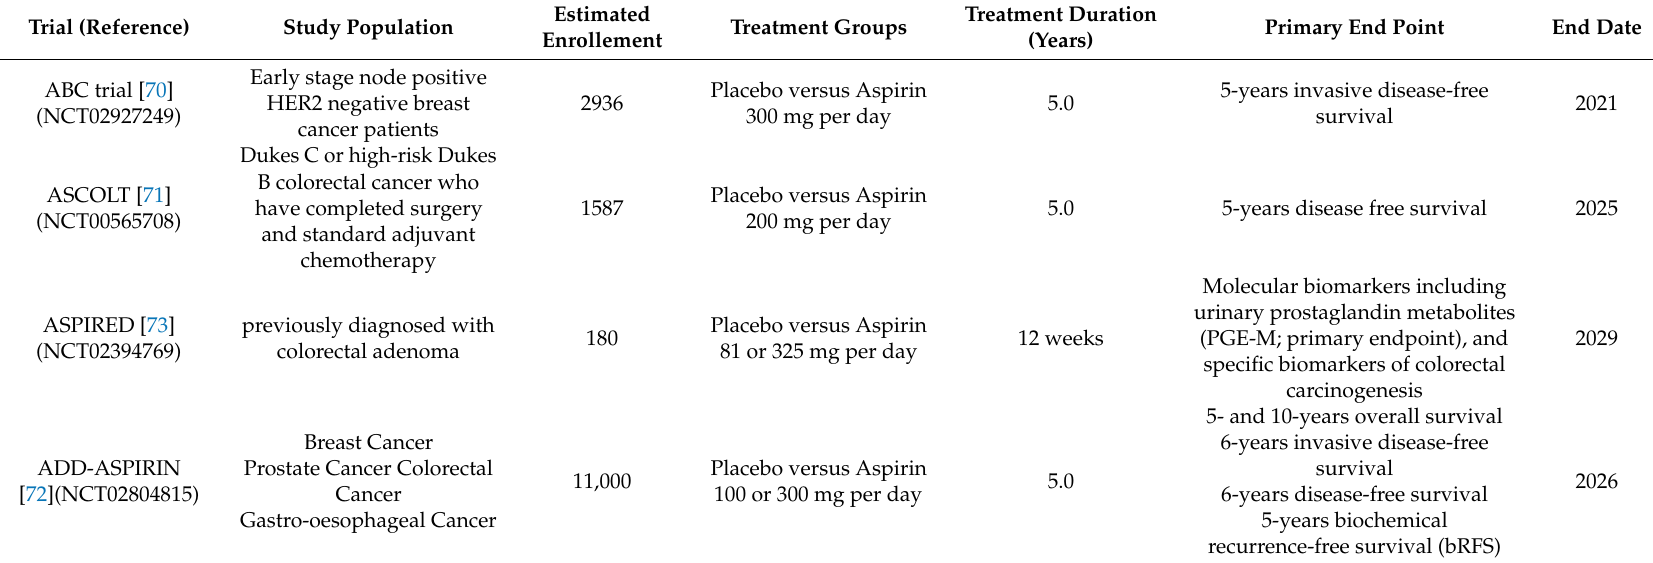
Table 3. Ongoing placebo-controlled trials of aspirin in patients with precancerous lesion or with